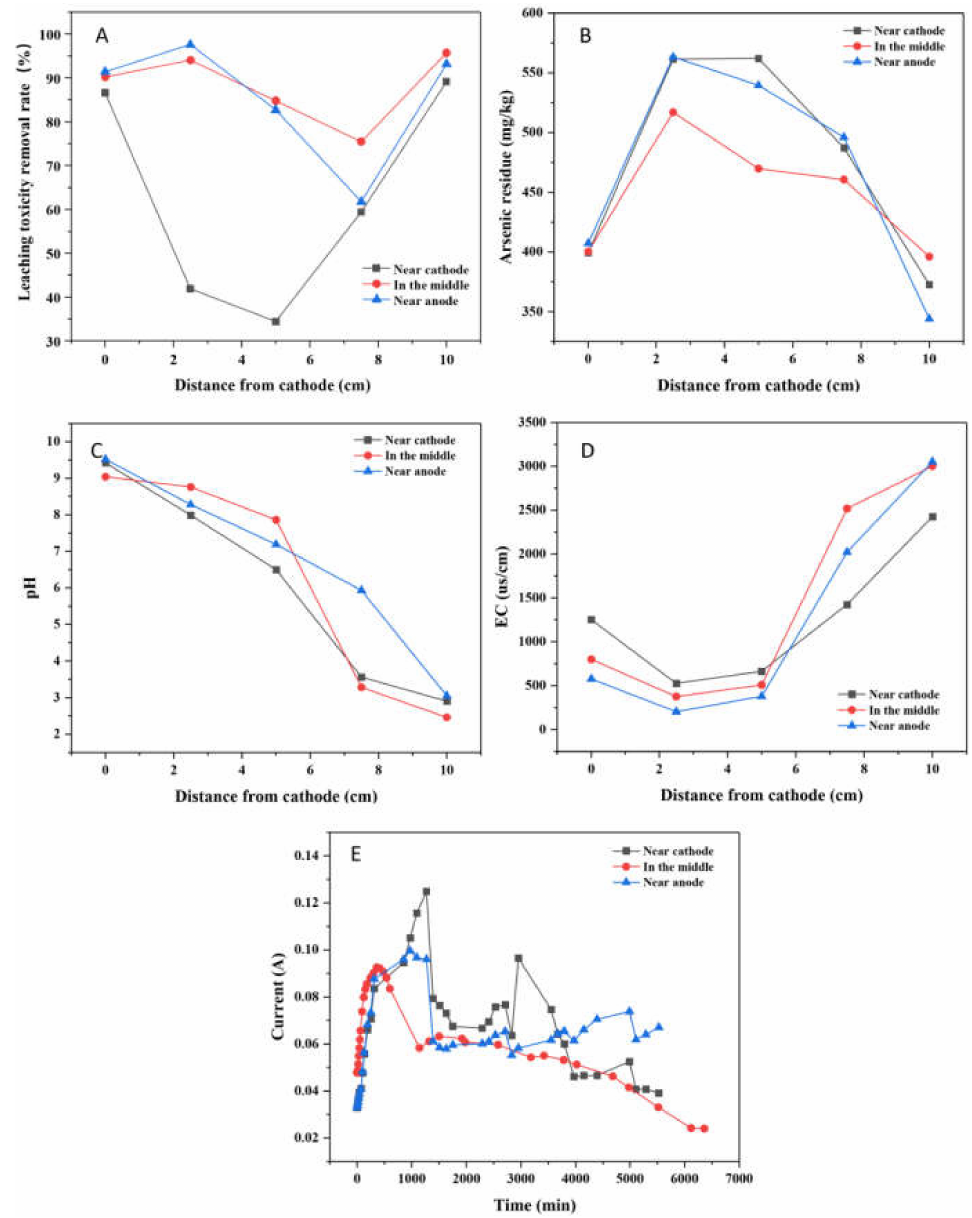
Figure 7. Effect of PRB position for the remediation of arsenic-contaminated soil by EK-PRB (Leaching toxicity removal rate ( A ), arsenic residue ( B ), pH ( C ), EC ( D ) and current ( E